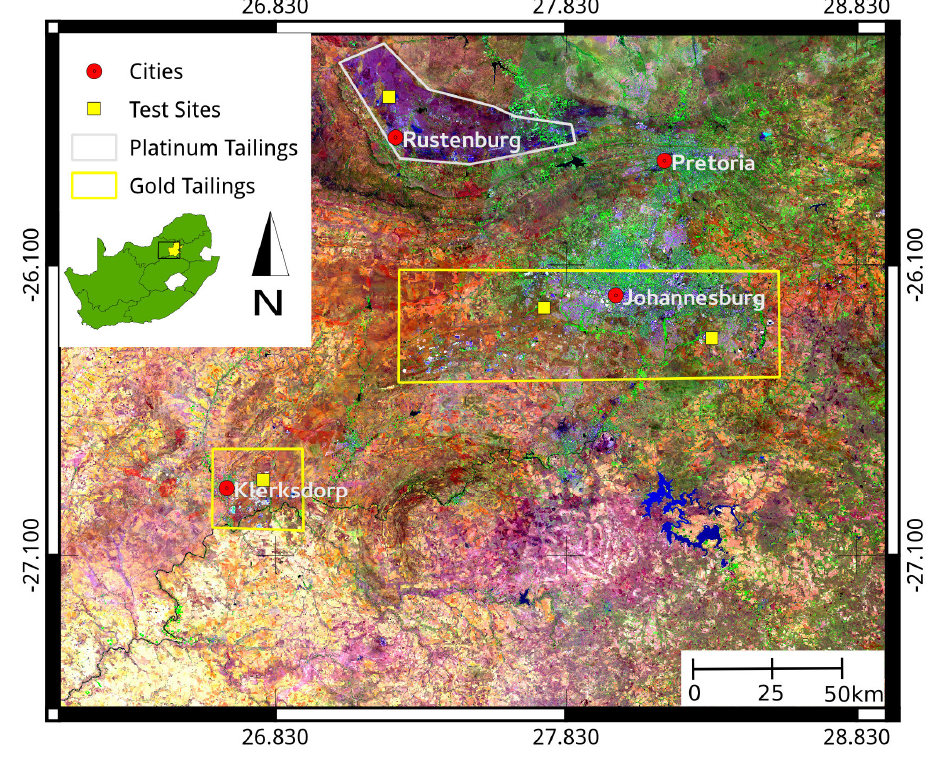
Figure 1. Landsat 8 composite (R: 2200 nm, G: 860 nm, B: 550 nm) showing the tailings facilities visited for this study (yellow stars). The yellow province in the inset map is Gauteng; the black box shows the boundaries of the study area. Note the extent of the Bushveld layered mafic intrusion (LMI), which can be distinguished by its dark